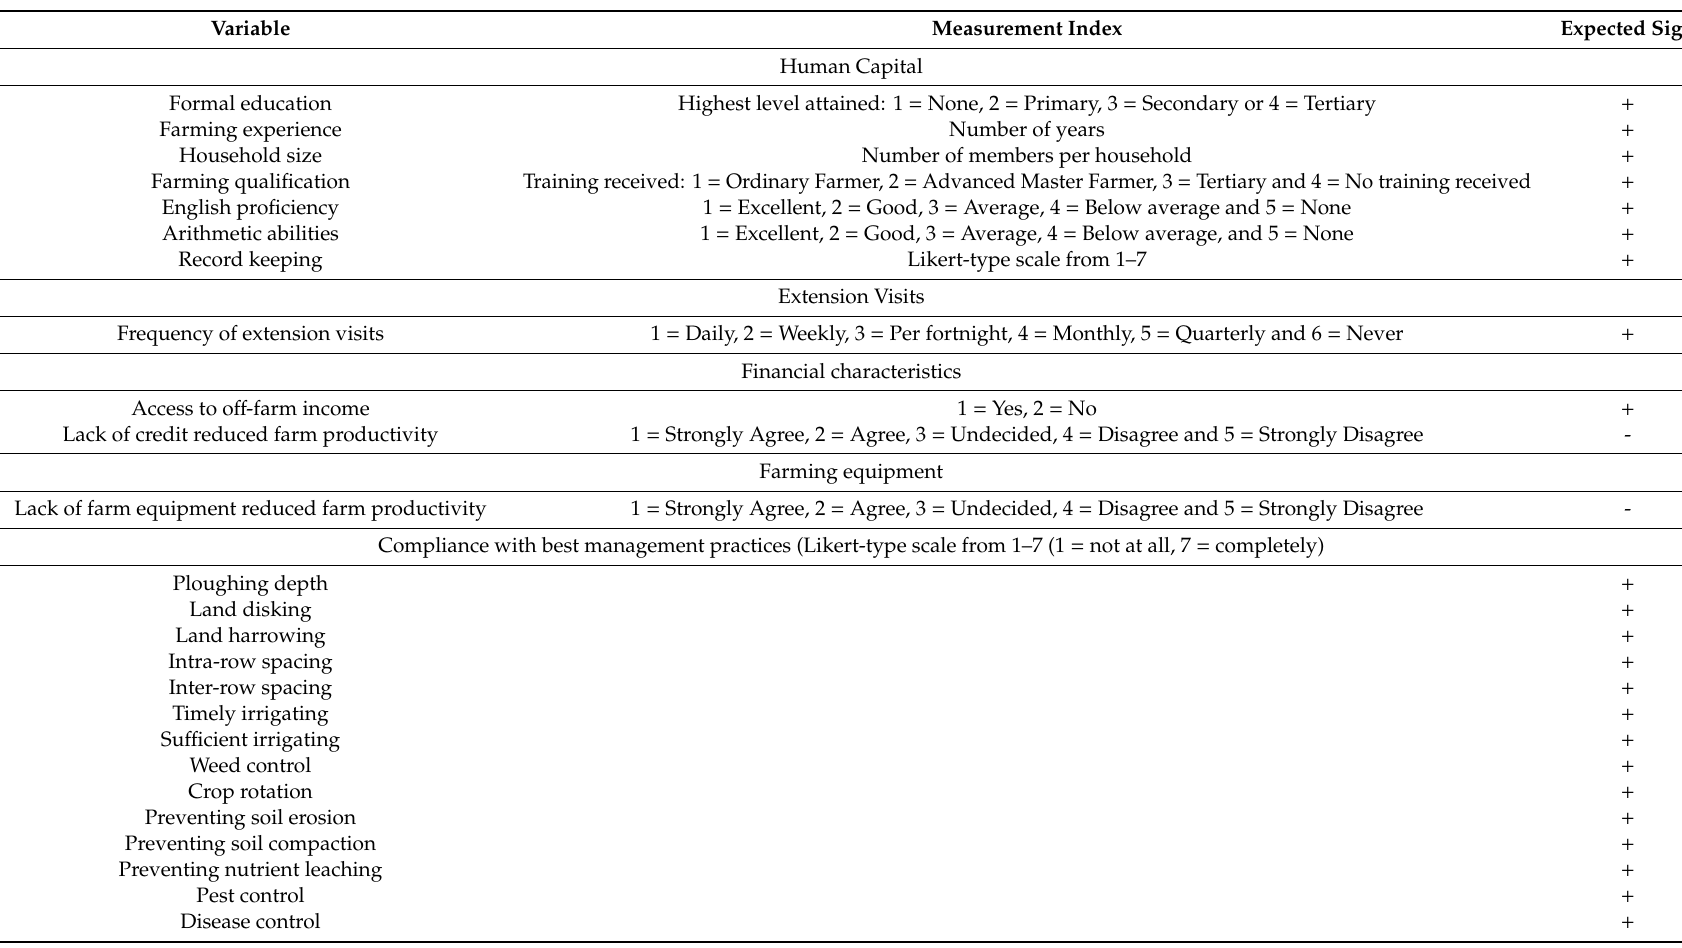
Table 1. Factors hypothesized to influence respondents’ technical e ffi